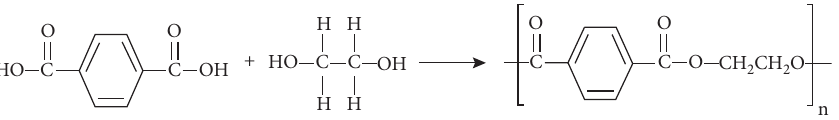
Figure 1: The polymerization reaction of terephthalic acid and ethylene